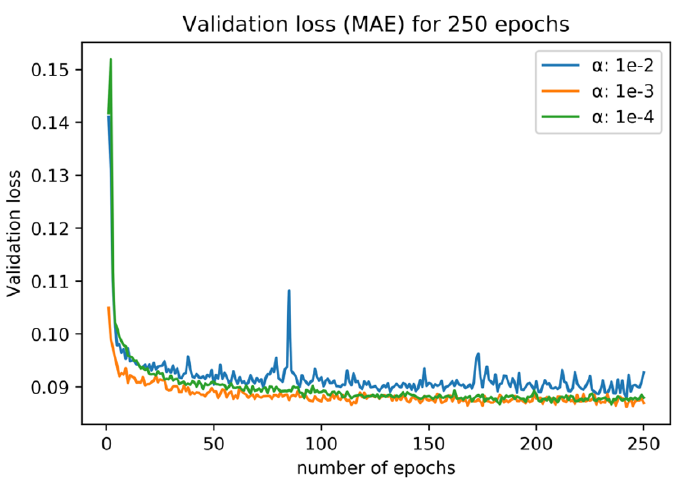
Figure 5. Average loss and validation loss (L1-norm) for the preliminary training experiment. Different colors represent different α values.